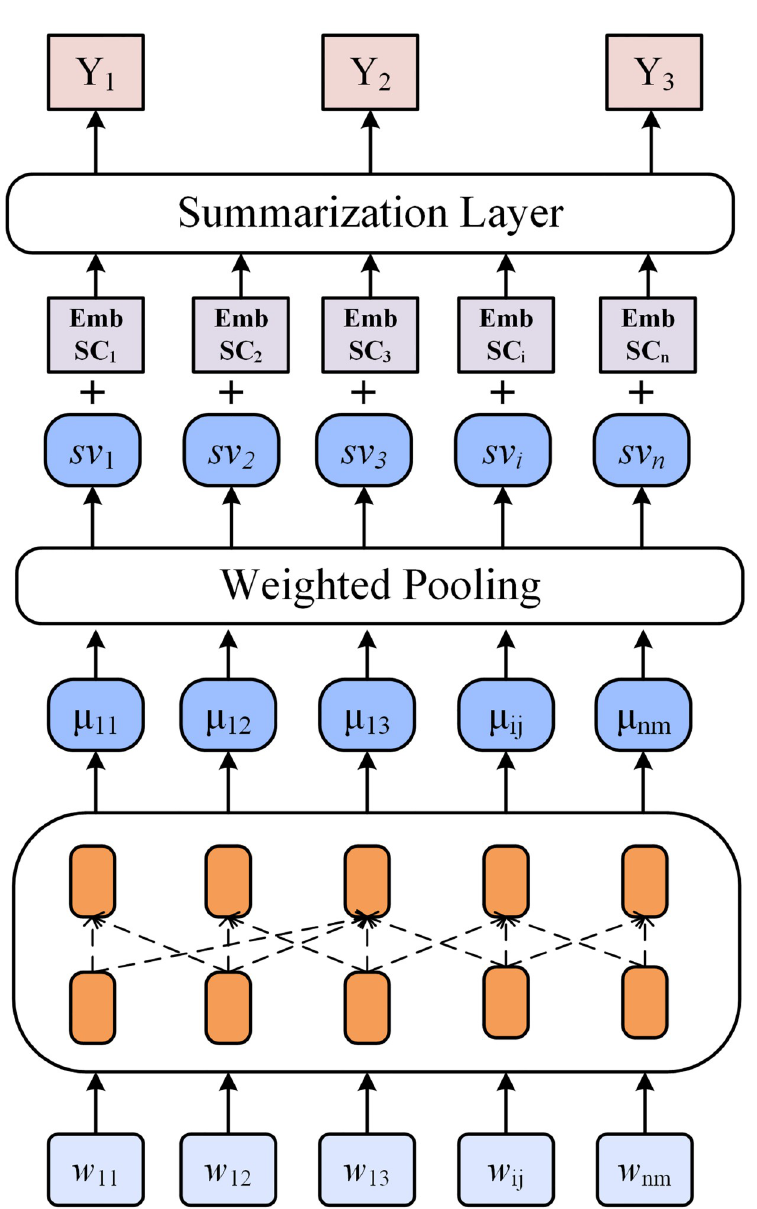
Fig 2. Sentence centrality-enhanced EDS model based on BERT. EmbSC i is the centrality embedding of sentence s i , which is directly embedded in the sentence representation generated by BERT. The sentence position embedding is replaced by sentence centrality